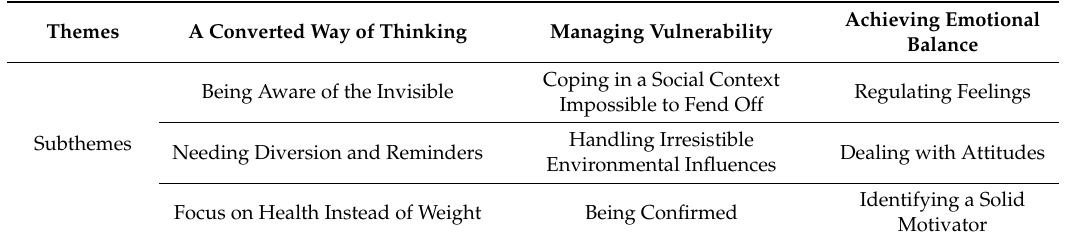
Table 3. The themes with the